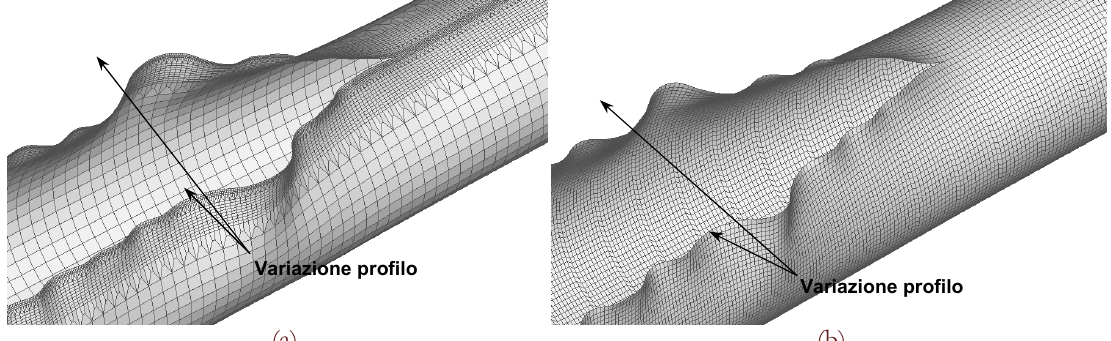
Figura 13: Effetto delle onde elastiche sul profilo di frattura per la mesh TIPO 1(a) e TIPO 2(b).